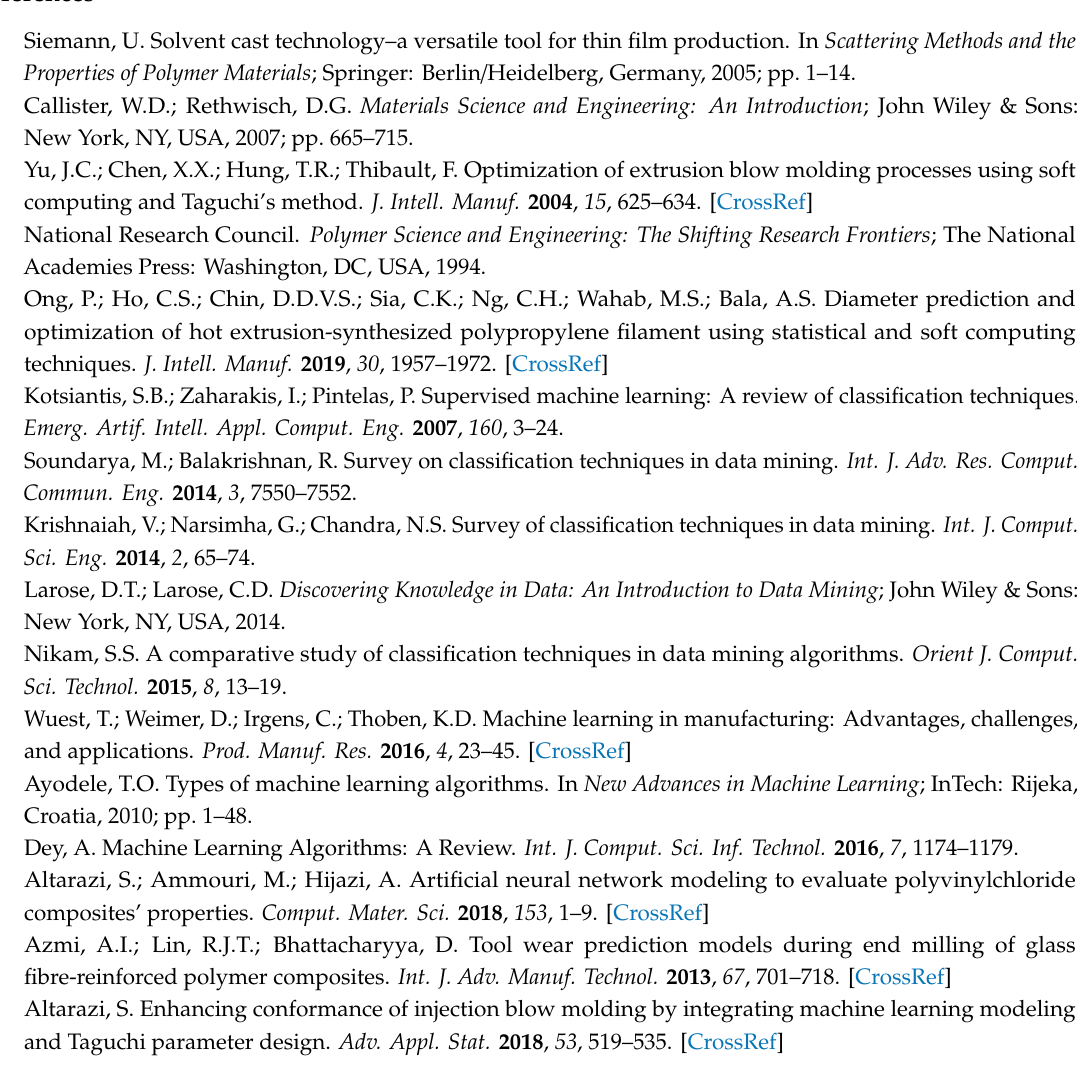
Figure S1: Screw of the extruder, Figure S2: Relationships of input parameters vs. tensile strength for the extrusion process, Table S1: Extrusion HDPE film experimental data set, Table S2: Compression molding film experimental data